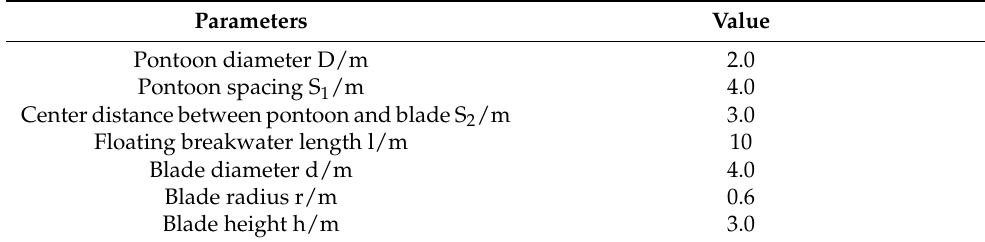
Figure 1. Tidal current period velocity segmentation flowchart. Table 1. Geometric features of